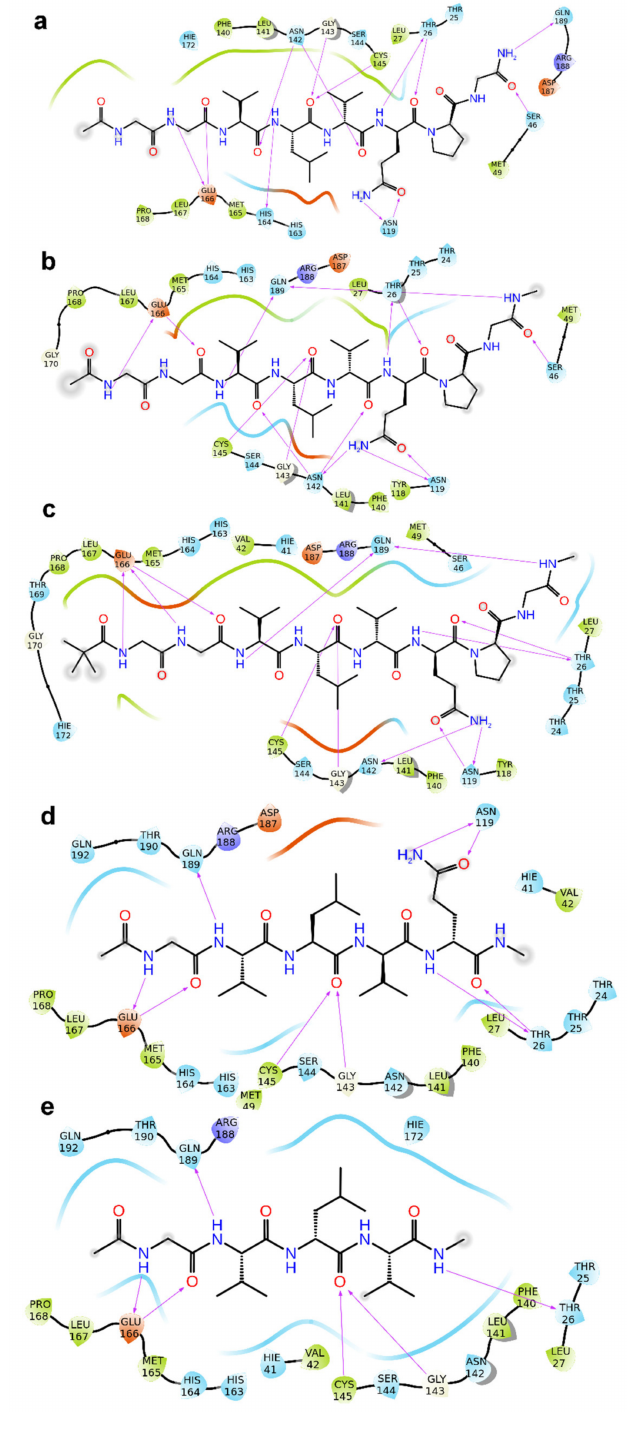
Figure 2. 2D panel representing interactions formed by fragments 2 ( a ), 3 ( b ), 4 ( c ), 5 ( d ) and 6 ( e ) with M pro . In each panel ( a – e ) the molecular structure of 2 – 6 is depicted in black, while the protein amino acids are indicated with three letter code, encircled with colored lines (negatively charged amino acids, red; positively charged amino acids, dark blue; polar amino acids, light blue; hydrophobic amino acids, green circles). The purple arrows indicate H-bonds. The arrows are directed from donor to acceptor of